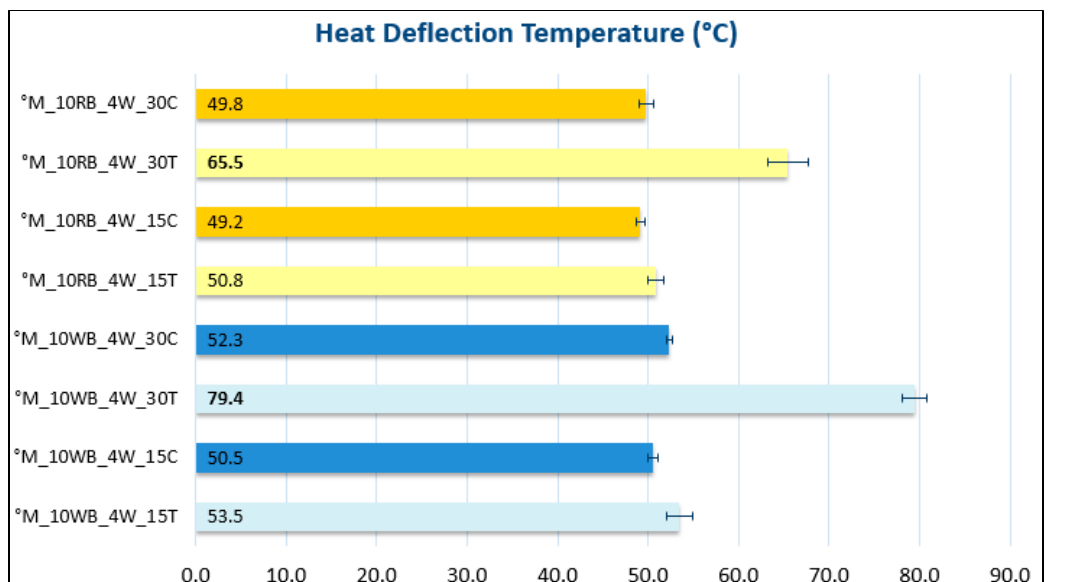
Table 4. Results of differential scanning calorimetry (DSC) analysis (first heating). Acronym